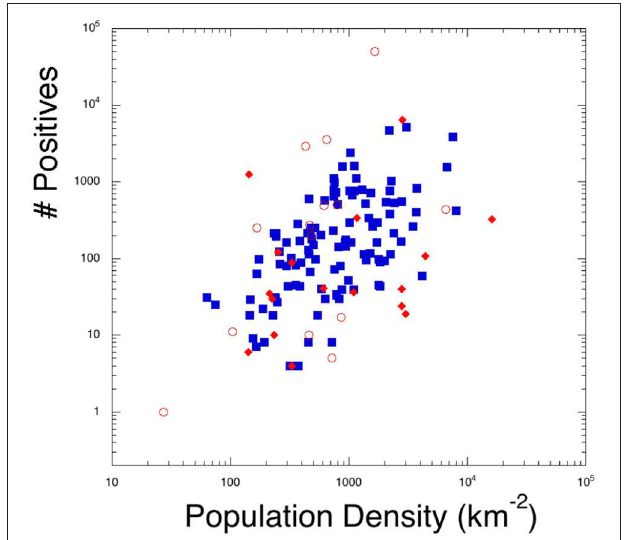
FIGURE 5 | Number of positive cases (on March 20,2020) to the virus as function of the density of population. All the Italian provinces (full squares), South Korean (full rhombs), and some Chinese ones (open circles) are included.